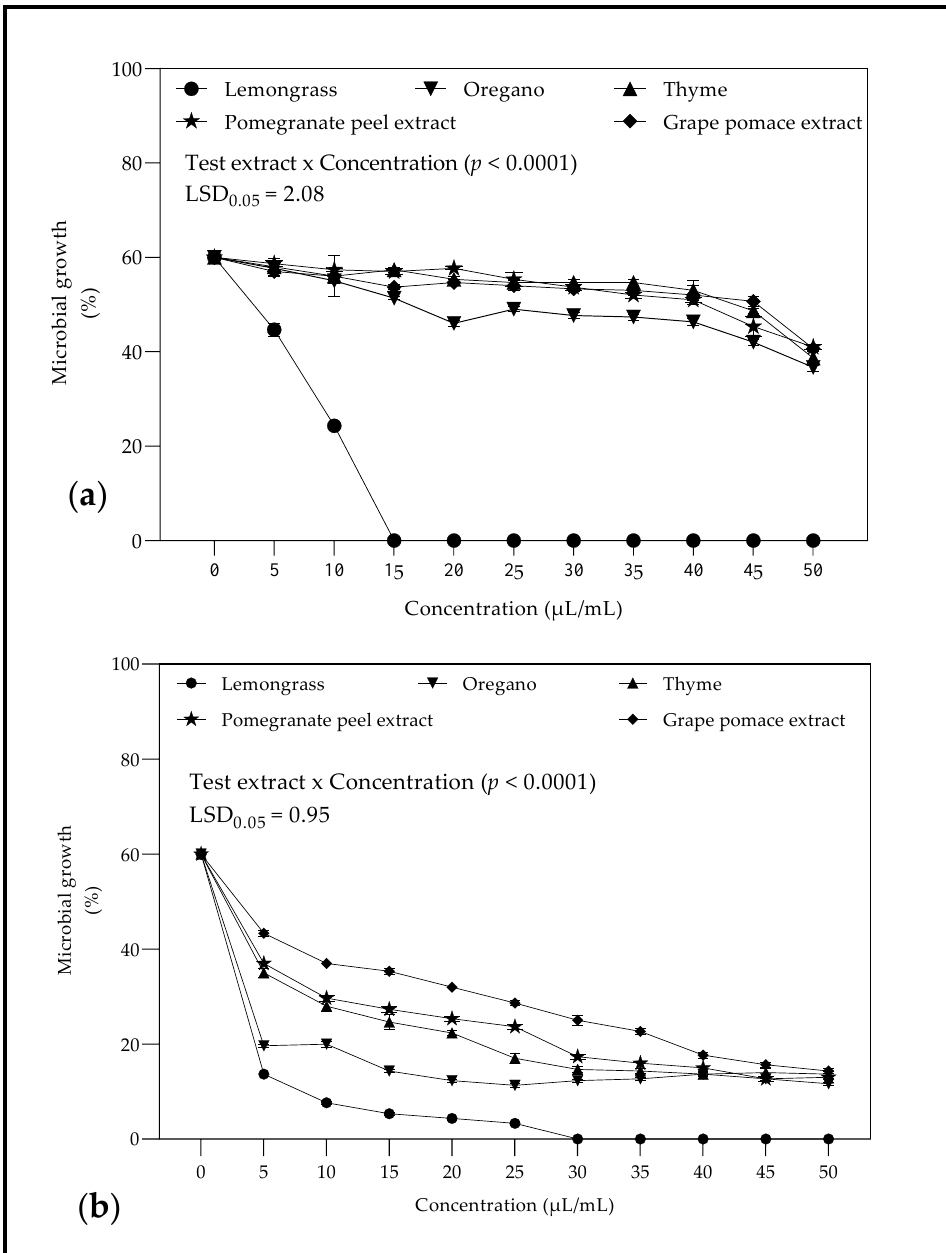
Figure 2. Antifungal activity (µL/mL) of essential oils and plants extracts indicating the minimum inhibitory concentration against ( a ) Botrytis cinerea and ( b ) Penicillium spp. Vertical bars represent the standard error (SE) of mean values of three replicates (1 plate = replicate). LSD 0.05 represent the least significant difference ( p < 0.05).